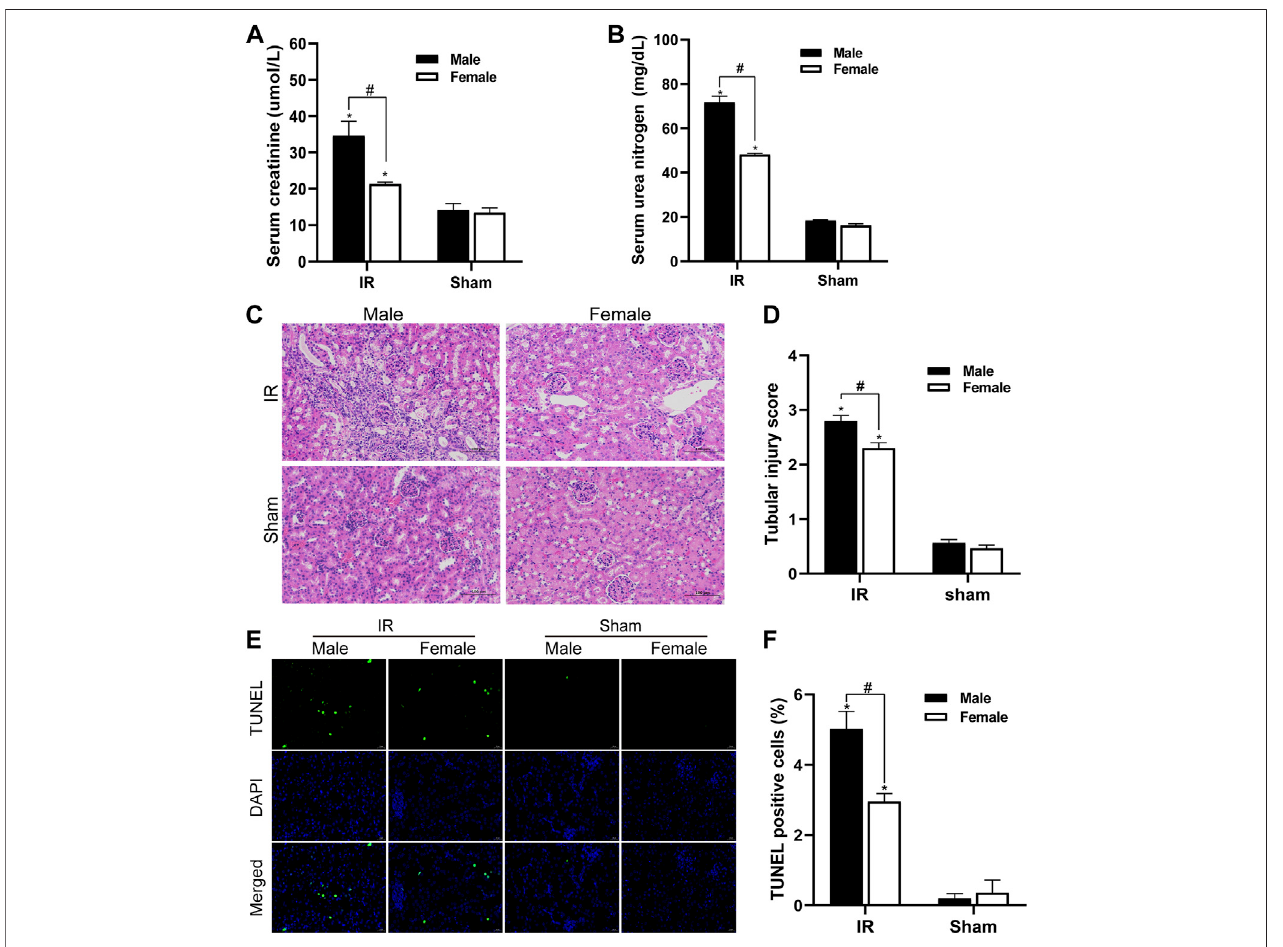
FIGURE1| Gender differencesinrenalischemia-reperfusion injury. (A,B) Serum creatinine levels (A) and serum urea nitrogen levels (B) ofmaleand female mice in renal ischemia for 45 min and 24 h after reperfusion. (C) HE staining of renal tissue (original magni fi cation ×200). Renal tubule injury is characterized by renal tubular atrophy and dilation, accompanied by tubular type. (D) Corresponding renal tissue pathological damage score. (E) Representative photograph for TUNEL staining section of renal tubular epithelial cells (green) in each group. Original magni fi cation: ×400. Scale bar: 20 µm. (F) Quantitative evaluation of TUNEL-positive cells in renal tissue. The data displayed are mean ± SEM ( n > 5). Compared with sham operation group, * p < 0.05. Compared with female renal IR group, # p < 0.05.